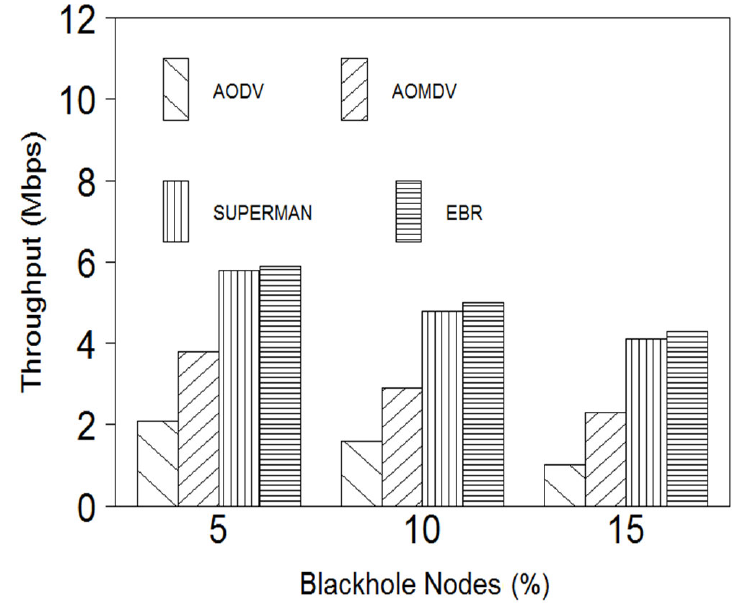
Figure 8. Throughput vs. blackhole nodes percentage.